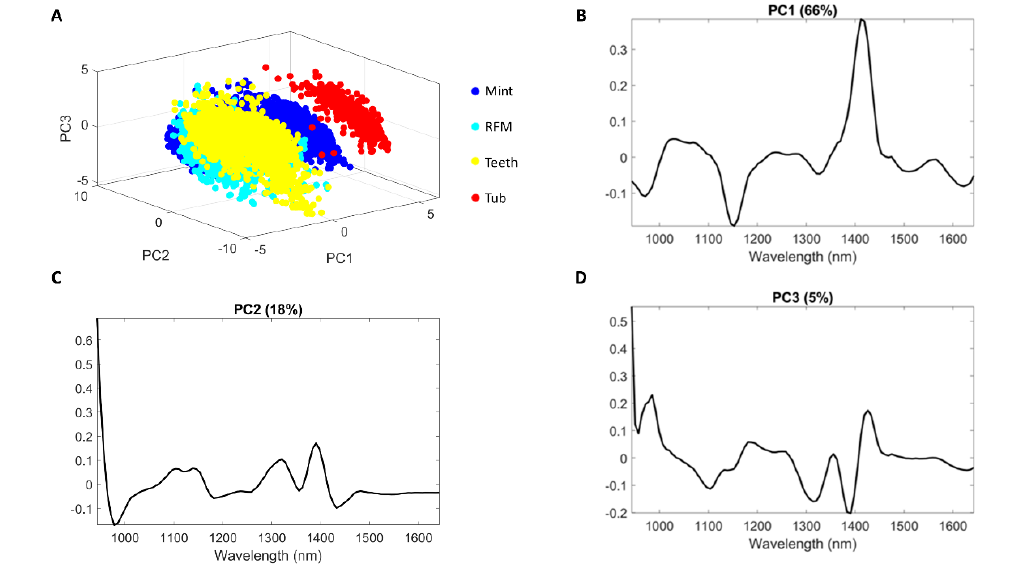
Figure 6. Principal component analysis score plots ( A ) and loading for PC1 ( B ), PC2 ( C ) and PC3 ( D